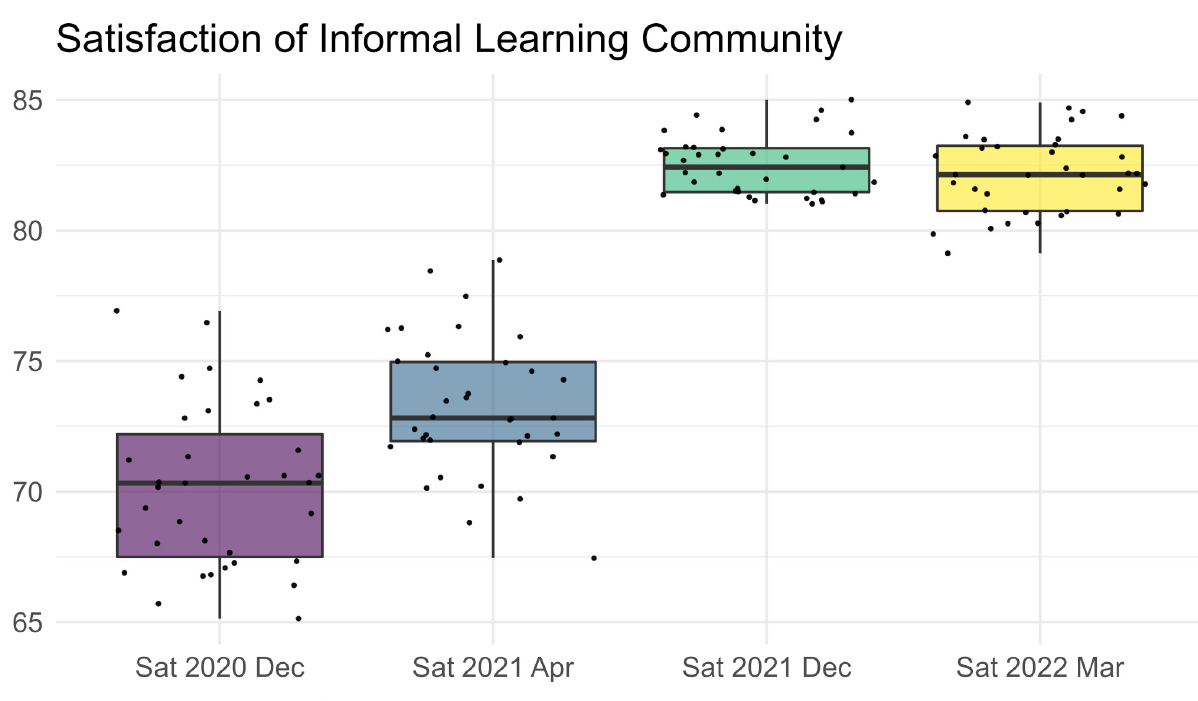
Fig 2. Results of satisfaction survey after each